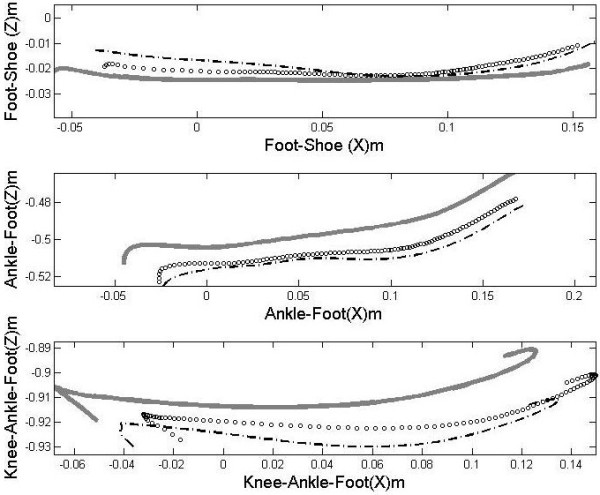
The foot-shoe, ankle–foot and knee–ankle–foot rollover shapes. Black dashed = MBT, Black circles = rollover shoe rollover footwear, Grey solid = flat shoe.